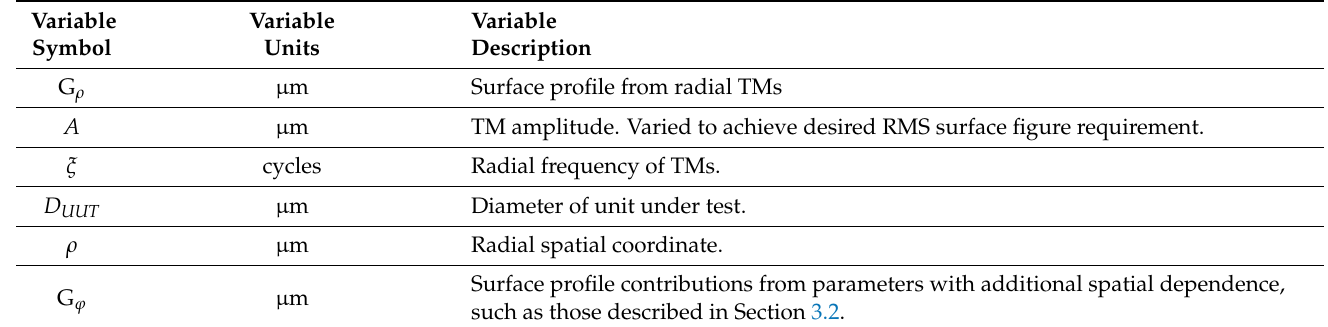
Table 1. Radial TM Variable